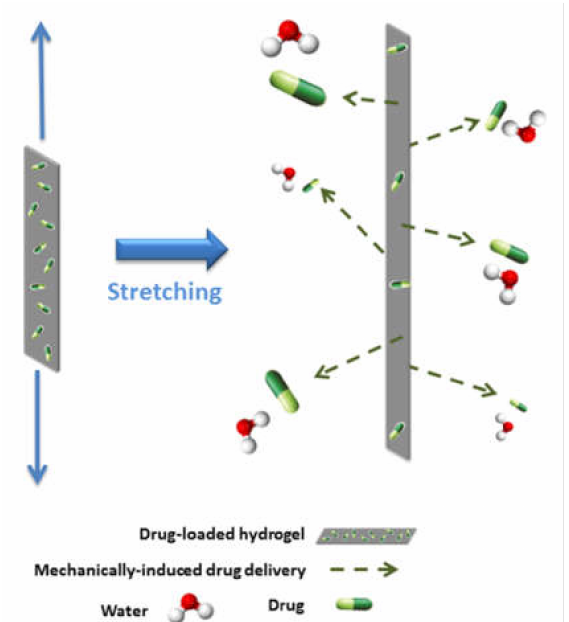
Figure 4. Example of mechanically responsive graphene hydrogel for drug release. Adapted with permission from Gonzalez-Dominguez, J.M. et al. (2018) [86] Copyright © 2021, American Chemi- cal Society.